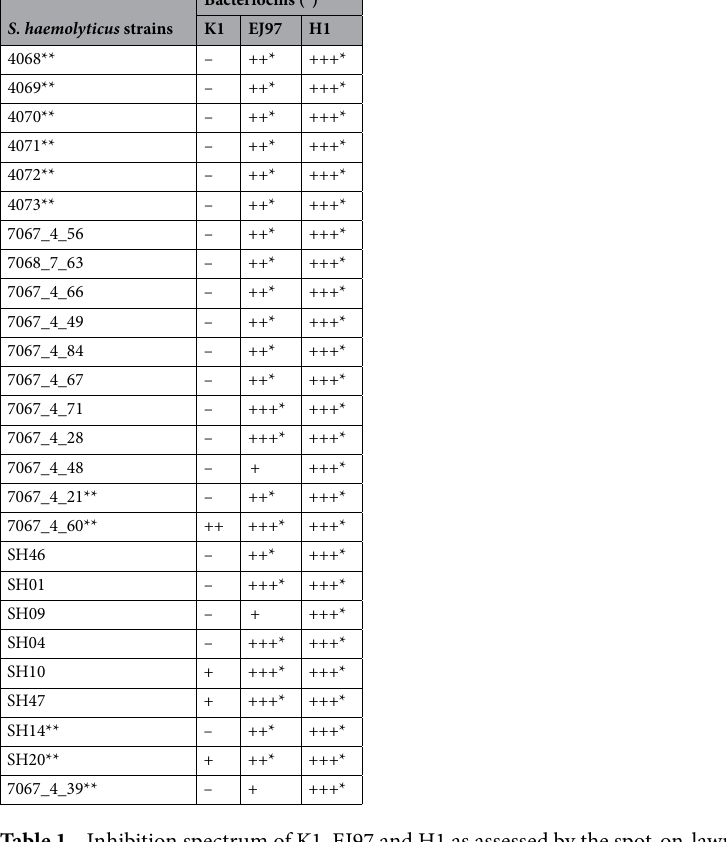
Table 1. Inhibition spectrum of K1, EJ97 and H1 as assessed by the spot-on-lawn assay against 27 Staphylococcus haemolyticus strains. *Mutants observed after 24 h. 5 μl of each bacteriocin at 1 mg/ml was used in the spot-on-lown assay. Average Inhibition score (n = 3) indicates: “−” = No inhibition; “+” = Unclear zone; “++” = zone < 1 cm, and “+++” = zone ≥ 1 cm. **Strains where H1 resistant mutants where isolated from 1 mg/ ml spot-on-lawn inhibition